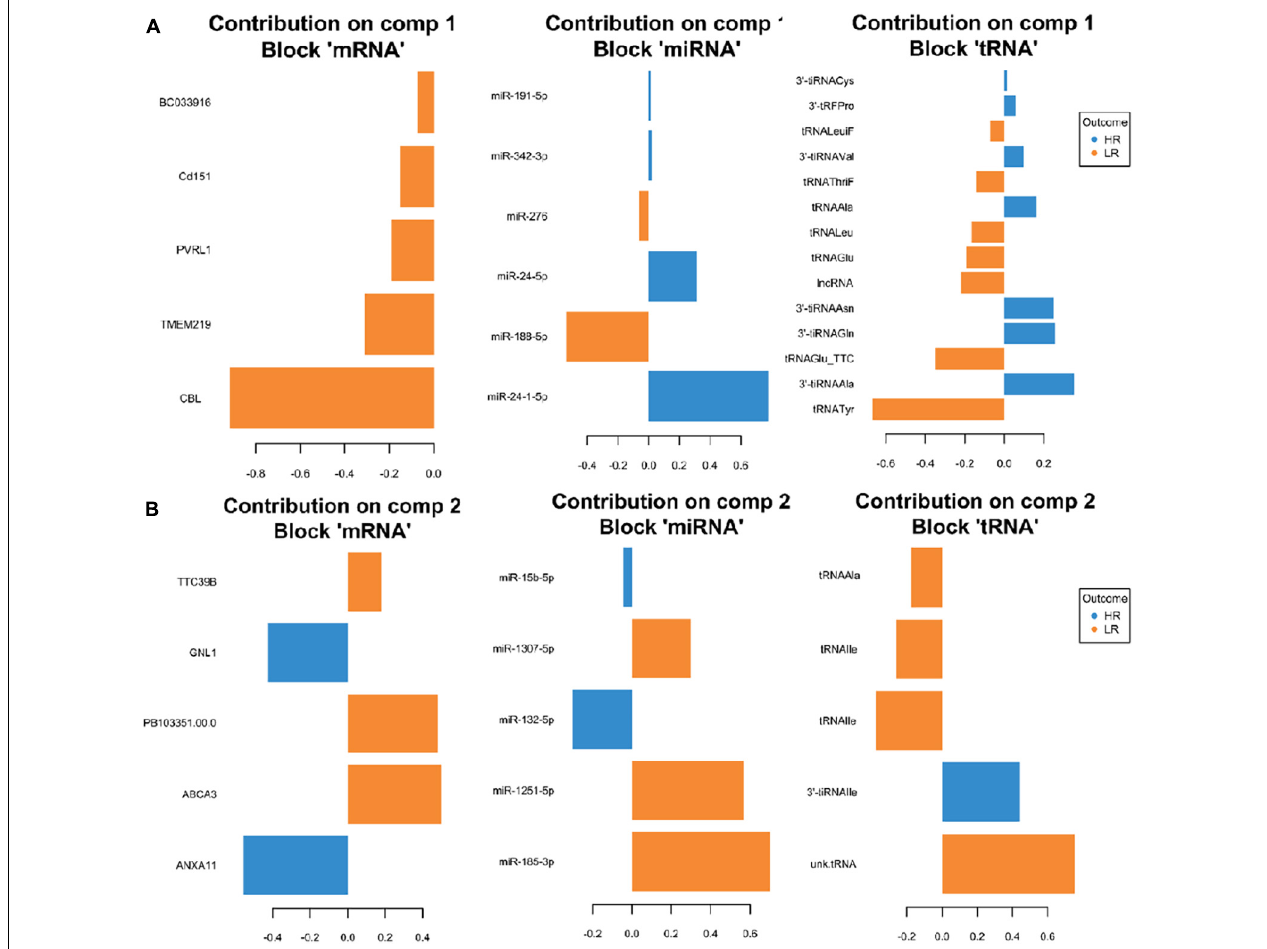
FIGURE 5 | Representation of the optimal biomarker panel of mRNA, miRNA, and tRNA correlated to coping behavior haplotype groups over two component sets in the hypothalamus. DIABLO minimal set of feature selection across data types could discriminate between high-reactive (HR) and low-reactive (LR) groups in component 1 (A) and component 2 (B) . Blue-colored bars are indicators for the HR group, yellow-colored bars indicate the LR group (DIABLO: Data Integration Analysis for Biomarker discovery using Latent